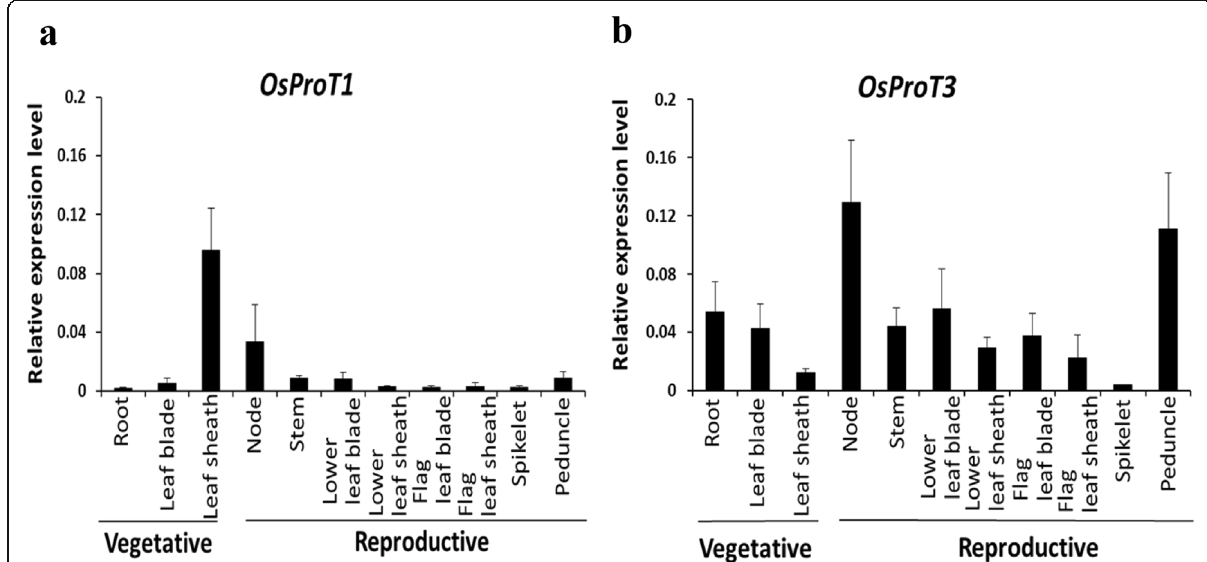
Fig. 6 Expression levels of OsProT1 and OsProT3 in different organs at vegetative and reproductive stages. a and b , Different samples were collected from rice grown in the soil. The expression levels of OsProT1 ( a ) and OsProT3 ( b ) were determined by real-time RT-PCR using the OsACTIN1 gene as internal control. Values are means ± SD, n =